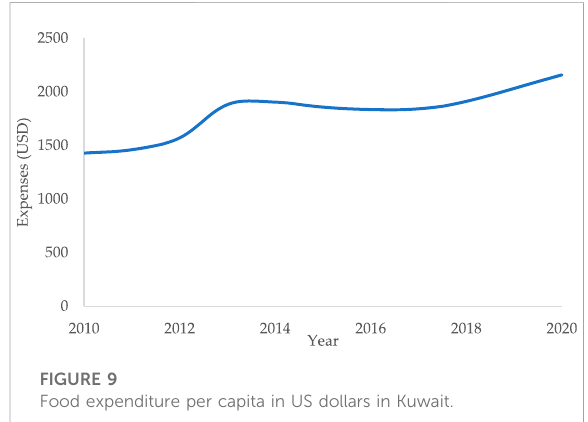
FIGURE 9 Food expenditure per capita in US dollars in Kuwait.